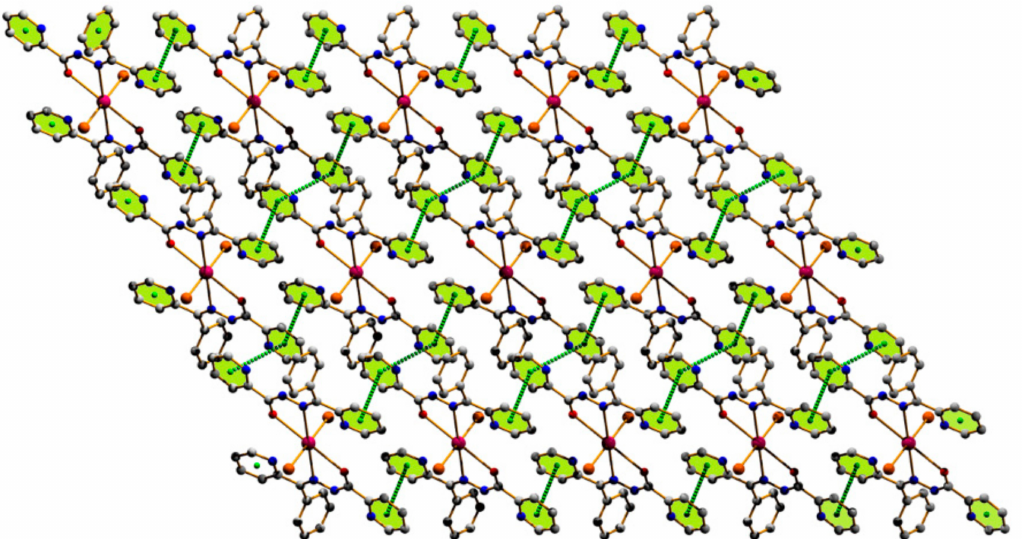
Figure 6. Supramolecular self-assembled network in ( 2 ) in (110) plane through the mixture of π - π stacking